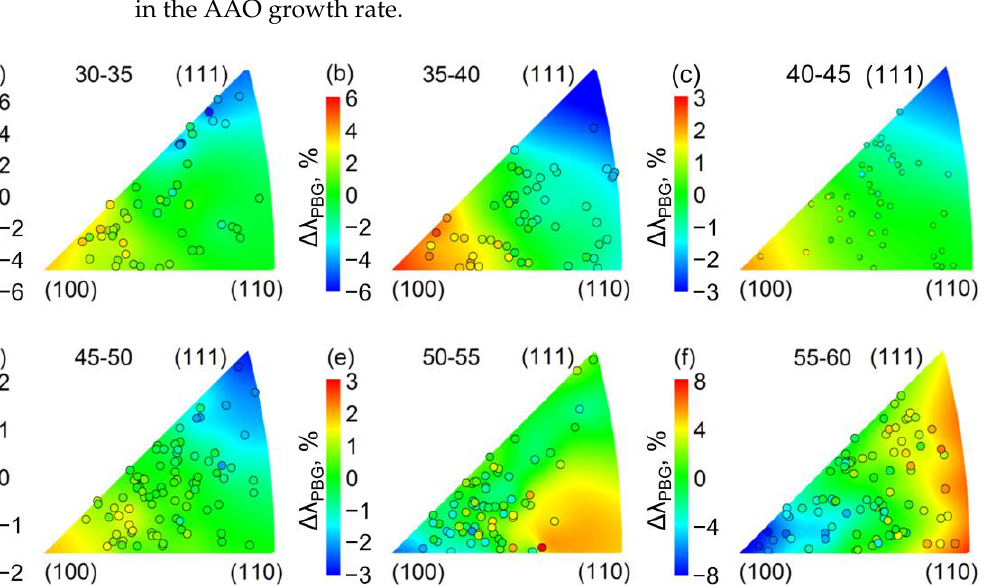
Figure 4. Dependence of the relative shift in the λ PBG on the crystallographic orientation of Al substrate in the normal direction for PhCs synthesised at 30–35 V ( a ), 35–40 V ( b ), 40–45 V ( c ), 45–50 V ( d ), 50–55 V ( e ), 55–60 V ( f ). Measurements were performed in air for dry samples. Data points are shown as circles filled with the colour corresponding to the relative deviation from average λ PBG and placed on the inverse pole figure in accordance with the crystallographic orientation of the Al grains. The colour map represents the smoothed experimental data for the relative shift of λ PBG .